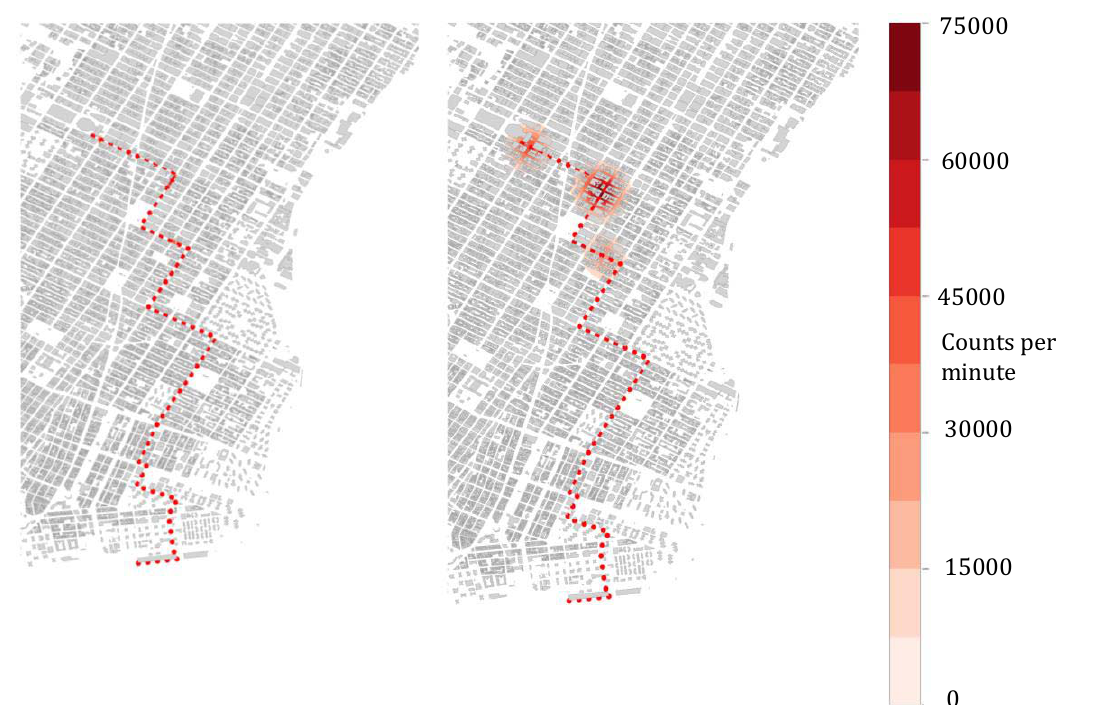
Figure 2. Detection heat maps. Maps show counts per minute detected from 200-vehicle mobile detector array of a 0.1 Ci Co-60 (left) and a 0.5 Ci Co-60 (right) source moving at 10m/s.